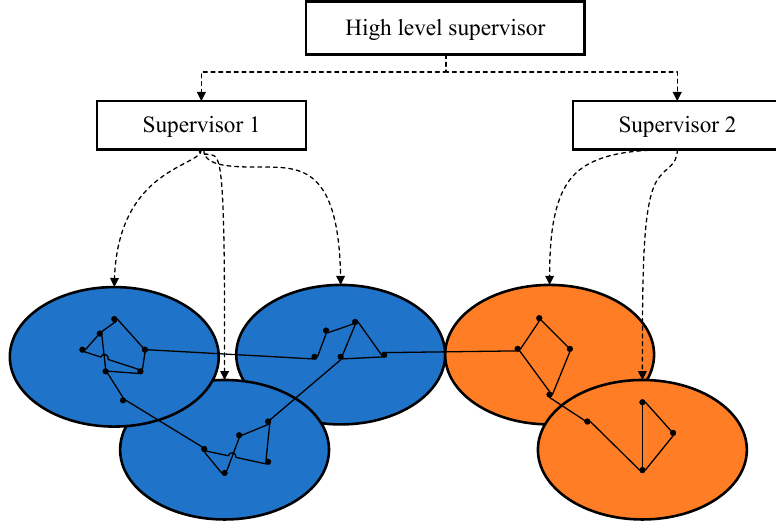
Figure 7. General structure of a hierarchical agent architecture .